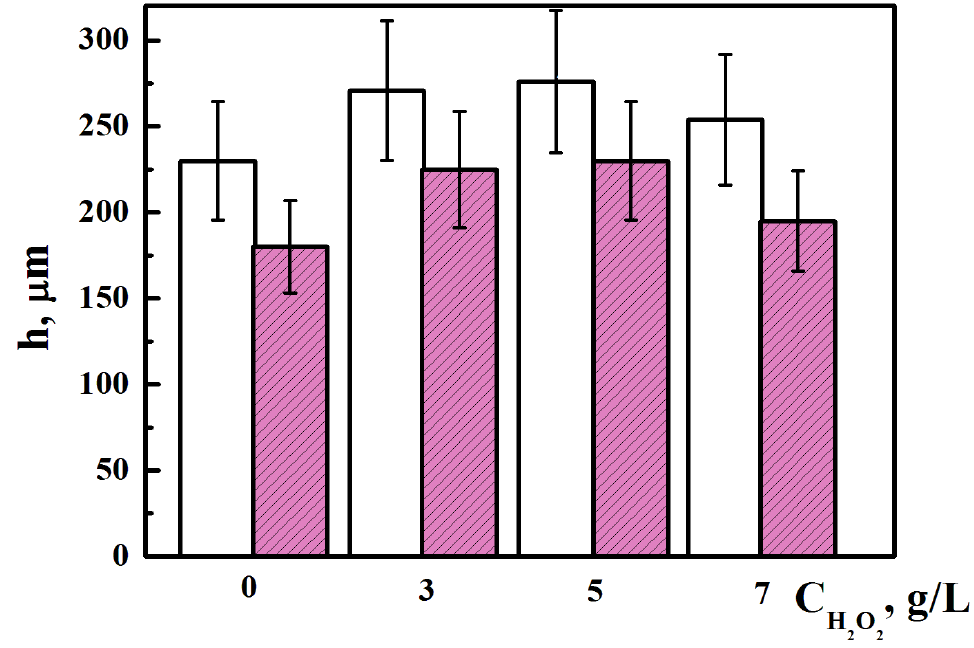
Figure 16. Effect of the amount of hydrogen peroxide C H2O2 in the main electrolyte on the thickness of PEO layers h on alloys AK-9 (white bars) and AK12 (dark bars).